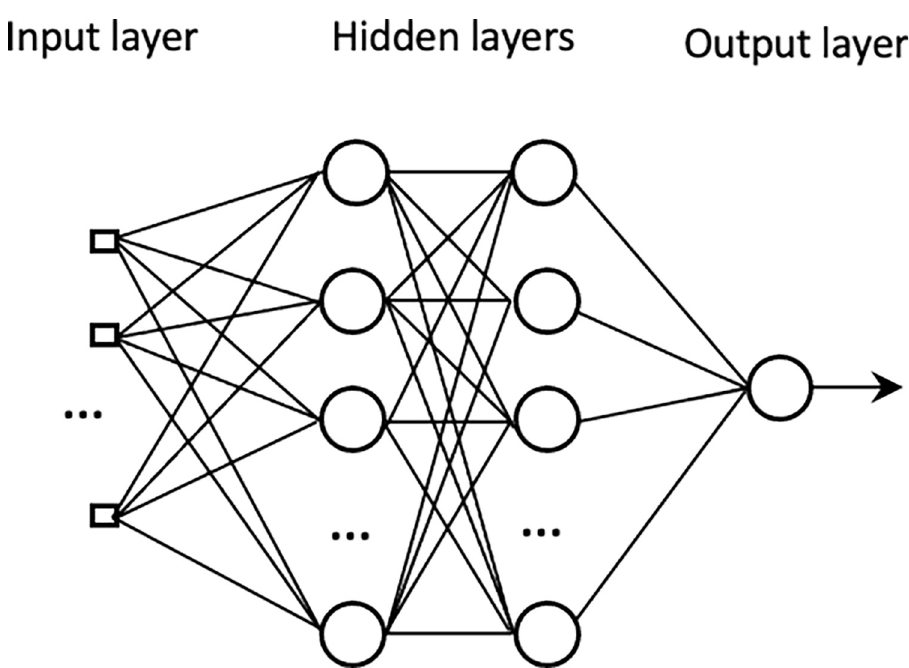
Fig 1. Structure of an MLP model with two hidden layers, and one output.